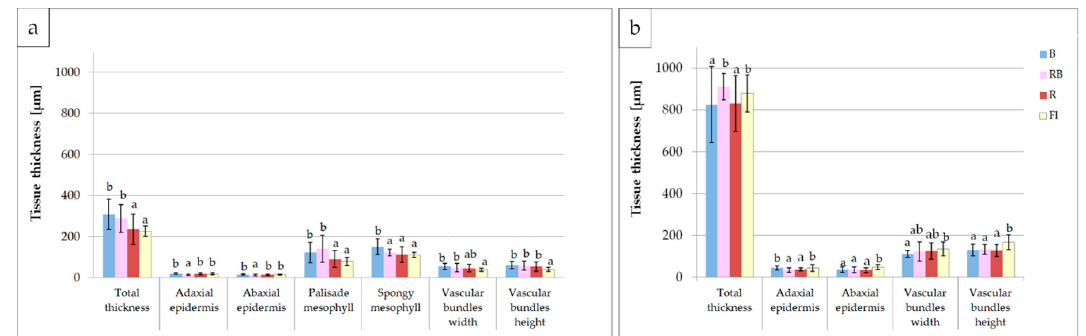
Figure 4. Characteristics of gerbera leaf anatomy: ( a ) blade and ( b ) petiole structure after 6 weeks of in vitro cultivation of shoots depending on the quality of light; B — 100% blue LED; RB — mixed red and blue LED (7:3); R — 100% red LED; Fl — control, white fluorescent lamp; tissue thickness in µm; mean values are presented with standard deviation bars; columns followed by the same letter are not significantly different according to Duncan’s multiple range test at p ≤ 0.05.